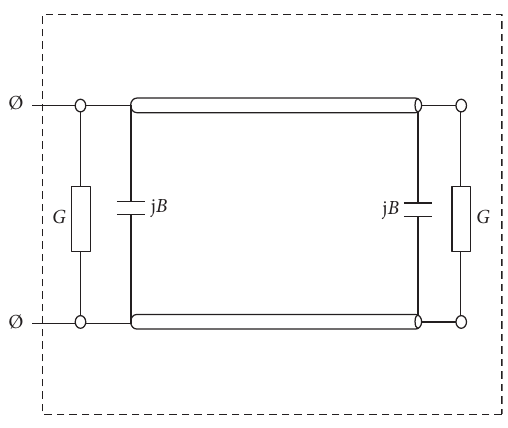
Figure 2: The equivalent circuit of microstrip patch.